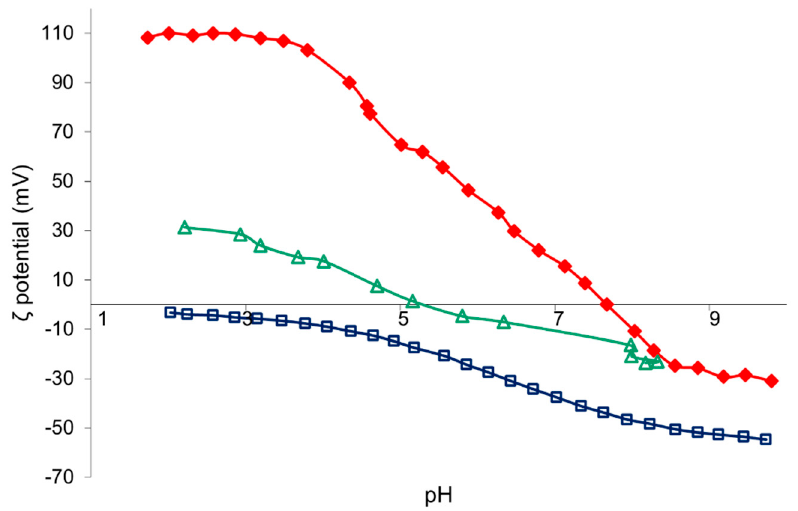
Figure 1. Z-potential vs. pH curves of TAC (red), SiO 2 (blue), and TiO 2 :SiO 2 (green) nanosuspension.